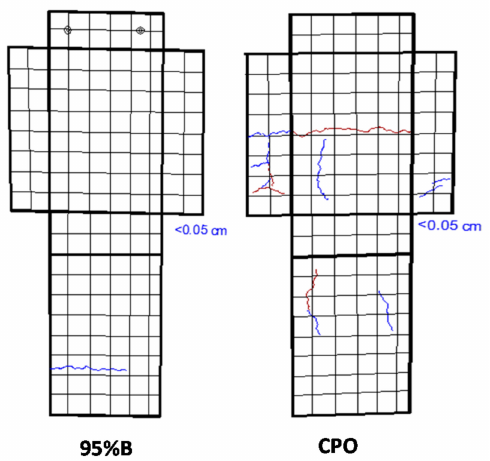
Figure 5. Typical surface crack survey.